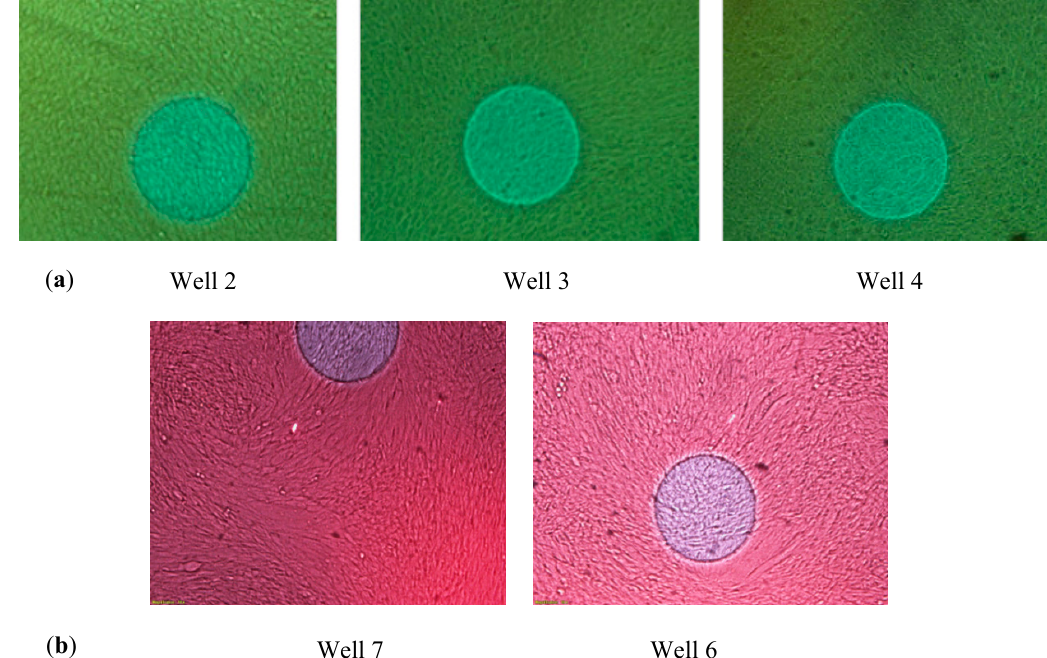
Figure 2. Comparison between monitored and non-monitored cell cultures. ( a ) Well 2 and Well 3 (stem cells without di ff erentiation, using electrical impedance) and Well 4 (stem cells without di ff erentiation, non-monitored), on day 8 of the experiment. No significant di ff erence is observed between them. ( b ) Well 7 (stem cells for di ff erentiation, without using electrical impedance), used as a control, on the eighth day after the start of the di ff erentiation process and Well 6 (stem cells for di ff erentiation, using electrical impedance) at the same time. No significant di ff erence is observed between Well 6 and Well 7 at any moment of the di ff erentiation process.